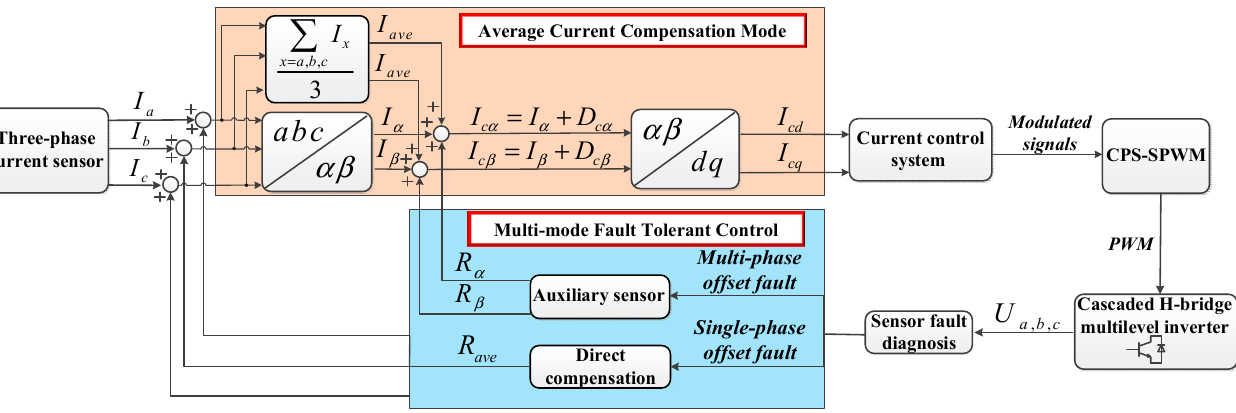
Figure 3. Block diagram of fault-tolerant control strategy based on average current